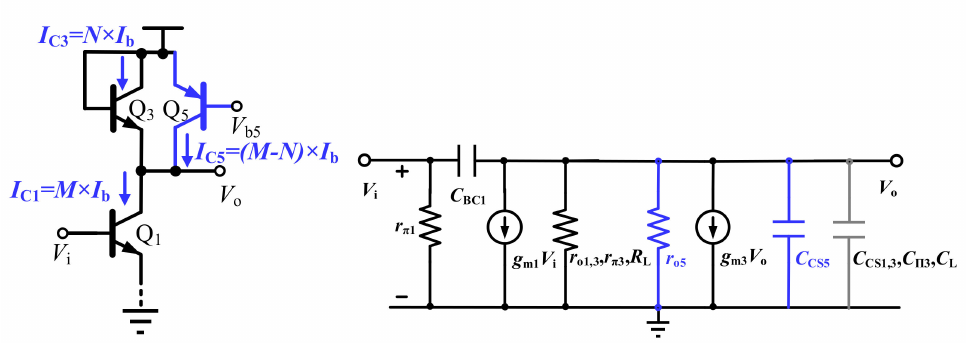
Figure 7. The simplified single-ended equivalent circuit and small signal model of the conventional gain